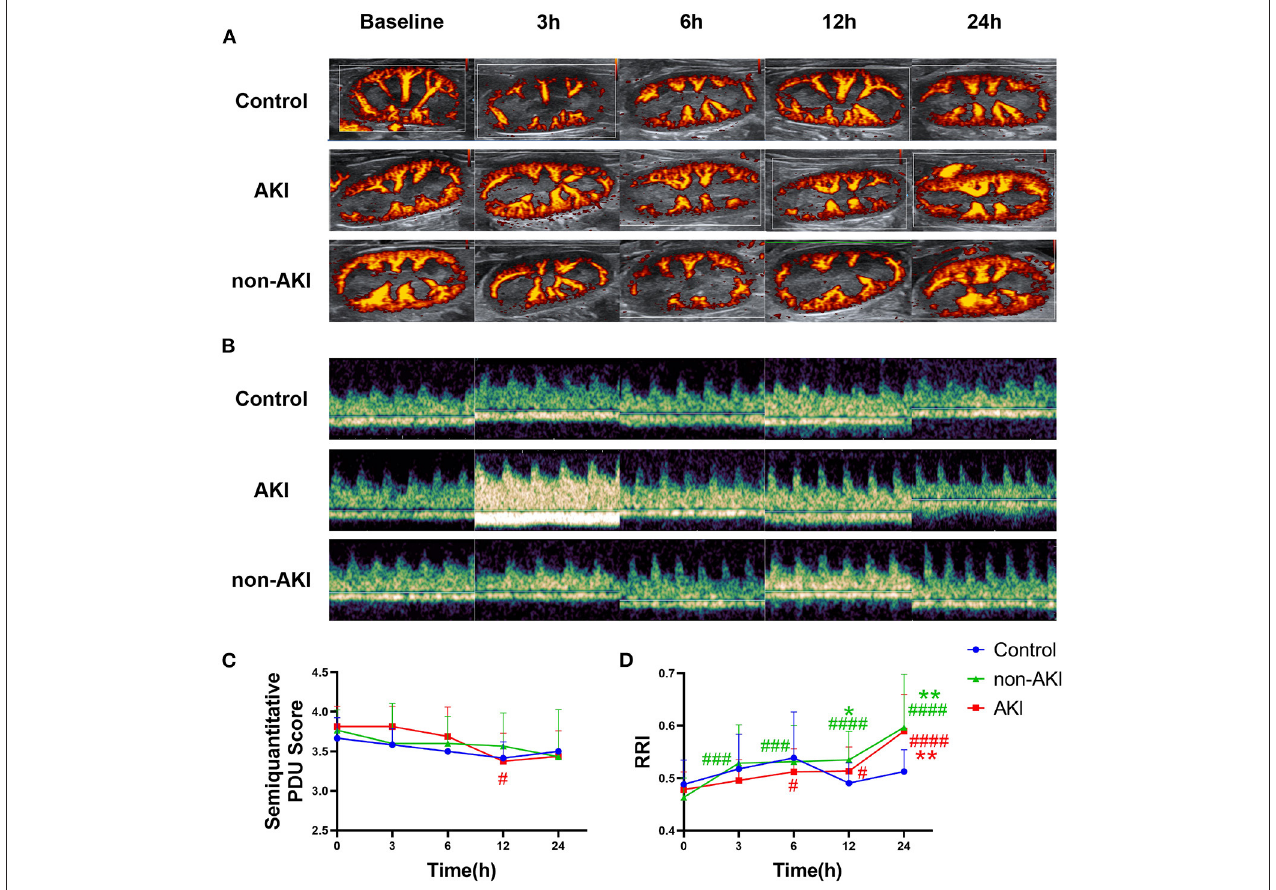
FIGURE 3 | Changes in renal ultrasonography during the observation from baseline to 24h after operation. (A) Example images showing the renal blood flow using power Doppler ultrasound (PDU) in control, AKI, and non-AKI groups at baseline, 3, 6, 12, and 24h. (B) Example images showing the renal resistive index (RRI) using pulsed wave Doppler in control, AKI, and non-AKI groups at baseline, 3, 6, 12, and 24h. (C) Changes of semi-quantitative PDU score over time. Changes in renal blood flow were relatively mild in each group, with only the AKI group showing a statistically significant decrease at 12h from baseline. (D) Changes of RRI over time. RRI increased gradually in both AKI and non-AKI groups. Compared with baseline, a significant increase in RRI first appeared at 3h in non-AKI group and at 6h in the AKI group. Compared with the control group, the RRI of non-AKI group was significantly higher at 12 and 24h, while significantly higher only at 24h in the AKI group. There was no significant difference in RRI between the AKI group and the non-AKI group at each time point. Data are expressed as mean ± SD. Using two-way repeated-measures ANOVA with the Geisser–Greenhouse correction, followed by Tukey’s multiple comparisons test or Sidak’s multiple comparisons test, P -values are shown. * P < 0.05, ** P < 0.01, compared to control group; # P < 0.05, ### P < 0.001, #### P < 0.0001, compared to baseline. AKI, acute kidney injury; PDU, power Doppler ultrasound; RRI, renal resistive